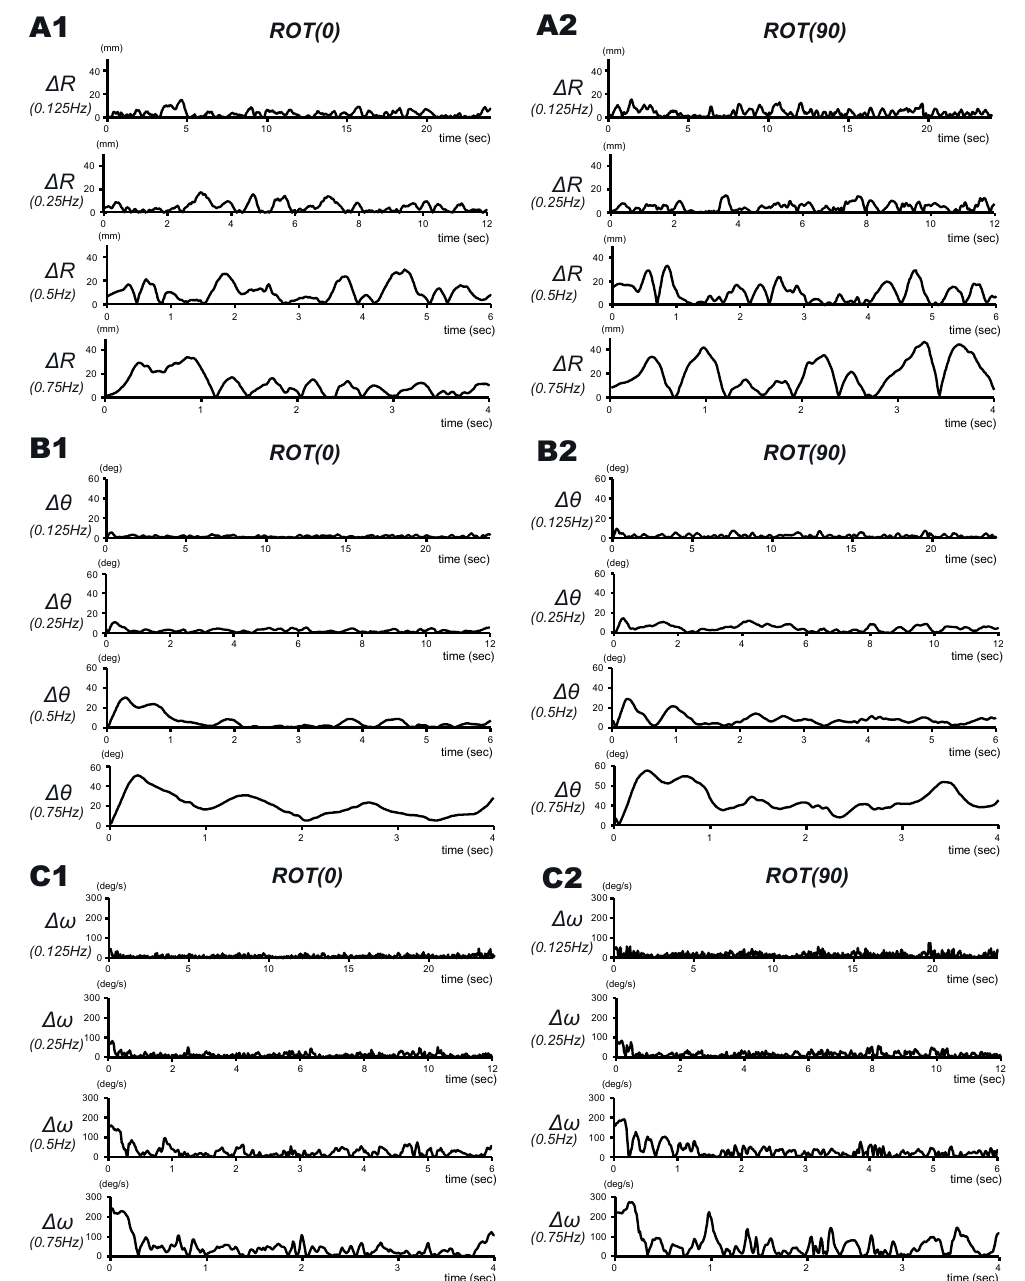
Figure 2. Typical examples of circular tracking movements for 0.125 Hz, 0.25 Hz, 0.5 Hz, and 0.75 Hz. ( A1 ) Absolute values of ∆ R for the frontal plane ( ROT (0)) and ( A2 ) the sagittal plane ( ROT (90)). ( B1 ) Absolute values of Δ θ for ROT (0) and ( B2 ) ROT (90). ( C1 ) Absolute values of Δ ω for ROT (0) and ( C2 ) ROT (90). ROT Next, we examined the Δ R circular tracking movement on each plane at the four target speeds. Figure 3B shows that the pairwise comparison had a significant Δ R difference for ROT (0) phase target speeds (item D in Table S1). The values of Δ R were 6.01 ± 3.53, 6.95 ± 3.24, 9.67 ± 1.72, and 13.11 ± 2.36 mm for 0.125, 0.25, 0.5, and 0.75 Hz, respectively. This indicates that Δ R increased significantly on the frontal plane ( ROT (0)) as the target speed increased.